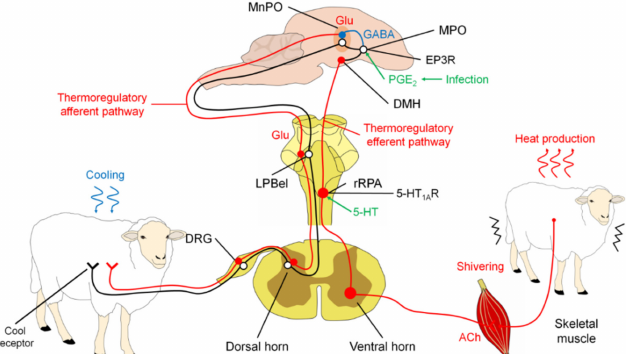
Figure 3. Mechanism of thermogenesis of skeletal muscle. In a cold environment (right), the skin’s cold receptors are activated, and cold sensory signals ascend to the POA through the dorsal horn and the outer lateral part of the lateral parabrachial nucleus (LPBel) and activate GABA neurons in the MnPO, and they then inhibit the GABAergic projection neurons in the MPO. The resulting disinhibition of DMH neurons leads to the activation of neurons in the rRPa, which eventually activates the somatomotor output of the ventral horn neurons, causing shivering. In the case of infection, PGE2, produced in the cerebral vasculature, attenuates the tonic activity of the GABAergic projection neurons in the MPO through the EP3 receptors and, therefore, disinhibits the DMH neurons that drive the output of febrile tremors through the rRPa and the ventral horn. Entry of serotonin into rRPa can inhibit premotor neuron activity through 5-HT1A receptors. Solid red, solid blue, and open black circles denote cell bodies of activated excitatory neurons, activated inhibitory neurons, and suppressed or resting neurons,